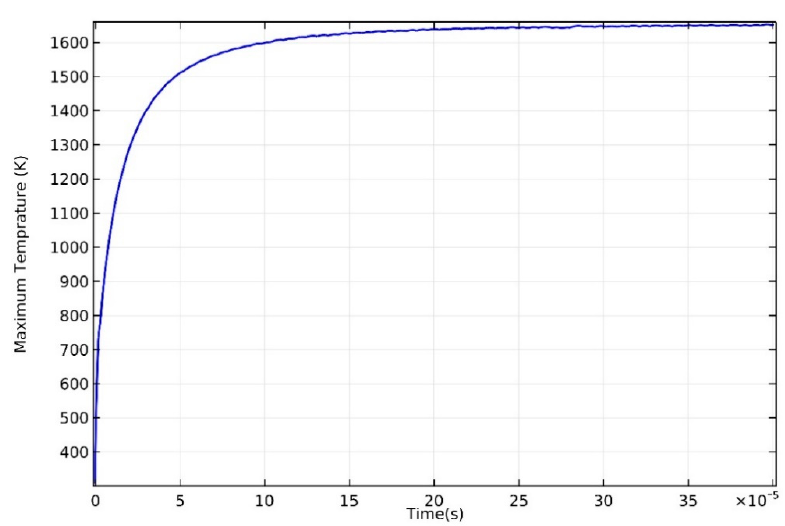
Figure 4. Maximum temperature of domain vs. time at 100 W.